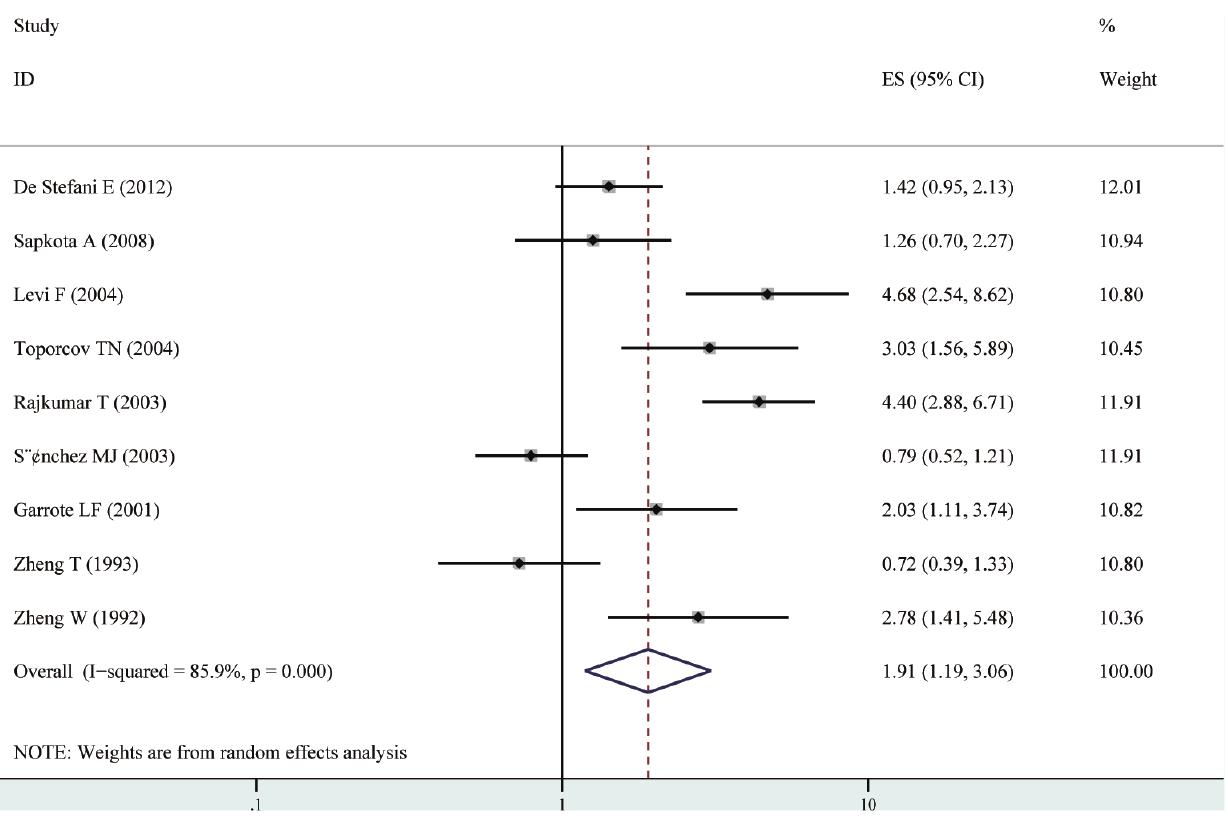
Figure 3. Forest plot: estimates (95% CIs) of processed meat consumption and risk of oral cavity and oropharynx cancer. Squares indicated study-specific risk estimates (size of square reflects the study-statistical weight, i.e. inverse of variance); horizontal lines indicate 95% confidence intervals; diamond indicates summary relative risk estimate with its corresponding 95% confidence interval.